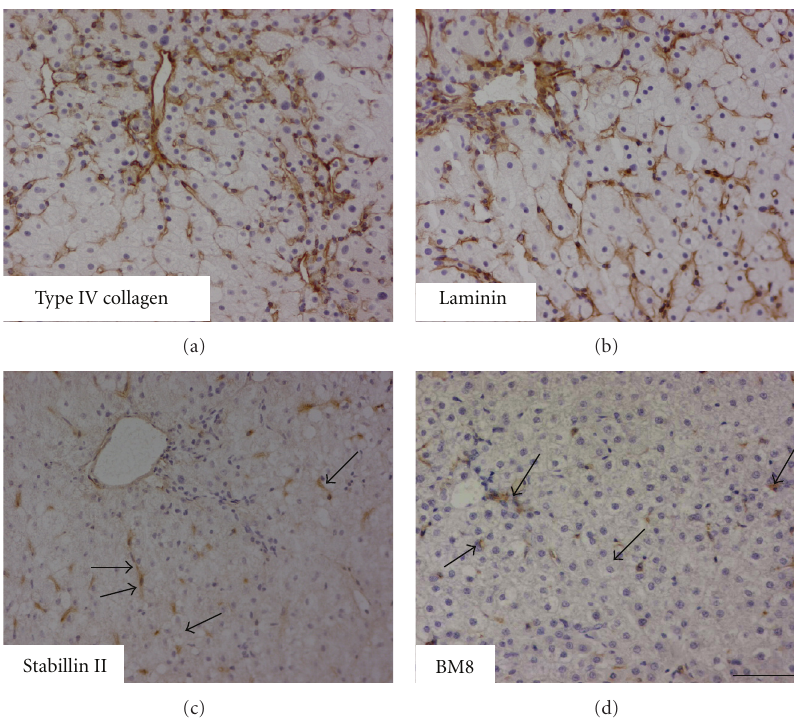
Figure 1: The histological harmonization of h -hepatocytes with m -nonparenchymal cells. uPA/SCID mice were transplanted with h - hepatocytes and allowed to grow until the repopulation of the liver was complete. Then, liver sections were prepared from the h -hepatocyte- chimeric mice. Sections were immunostained with m -specific antibodies for type IV collagen (a); laminin (b); stabillin (c), a marker of liver endothelial cells (a gift from Dr. A. Miyajima, Tokyo University); and BM8 (d), a marker of Kup ff er cells. The immunosignals are brown. The arrows in (c) and (d) point to typical immunopositive cells. Bar, 100 μ